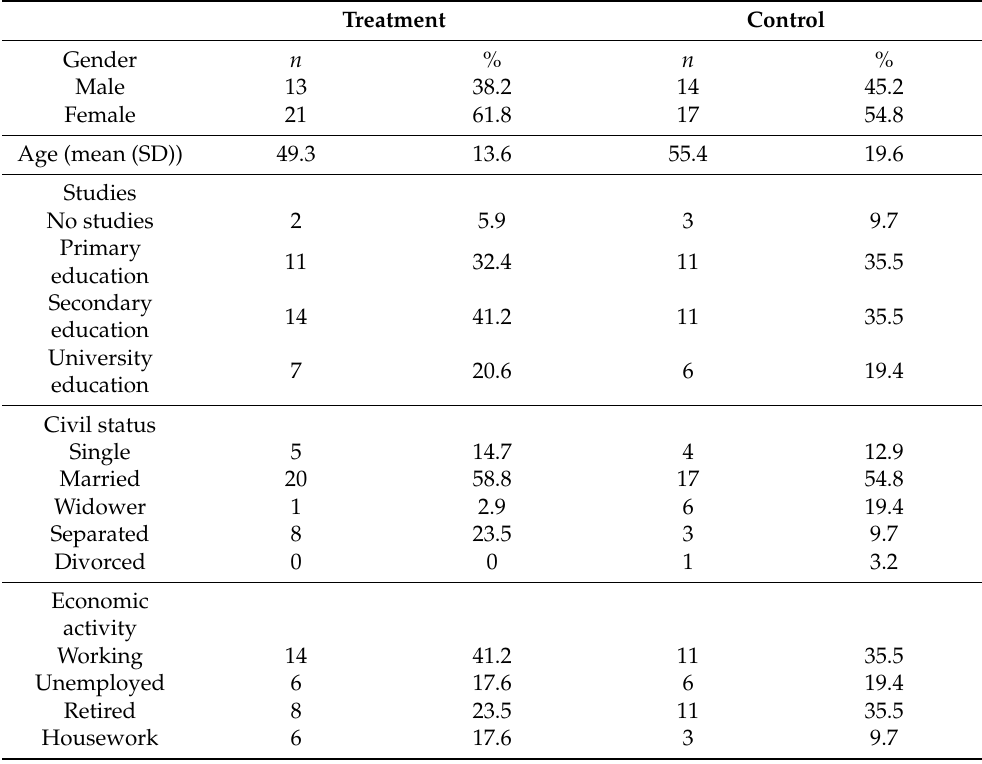
Table 3. Subject sociodemographic characteristics at